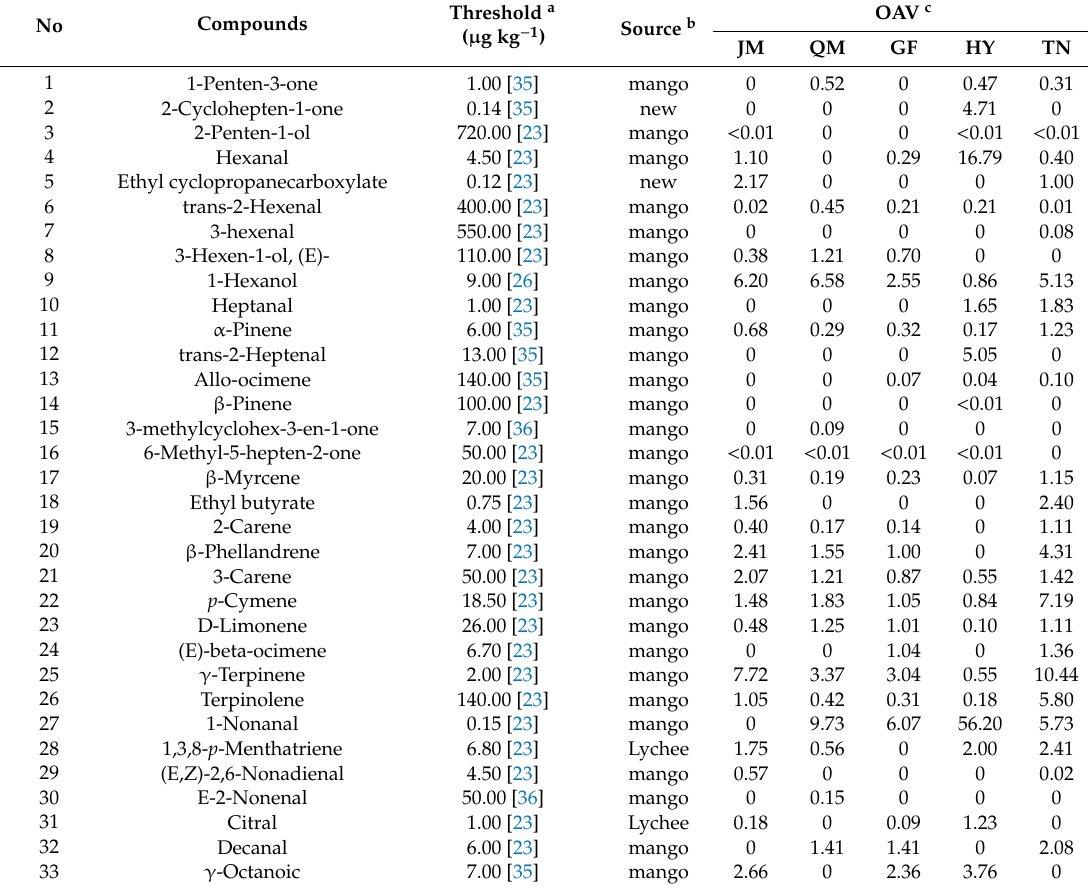
Table 3. Concentrations and calculations of odor activity values (OAVs) of the important aroma-active compounds in mango